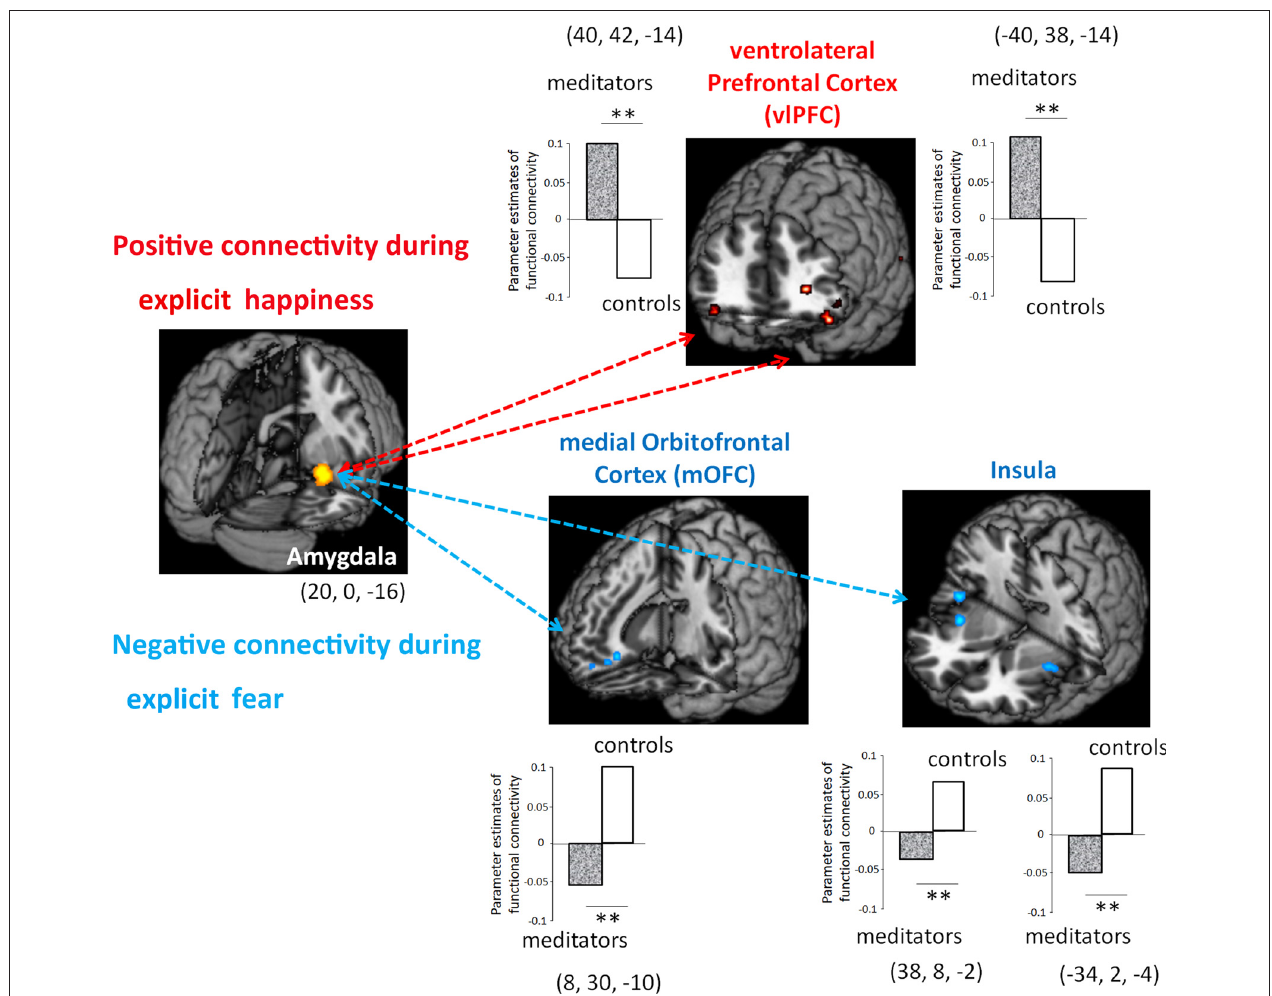
FIGURE 3 | Functional connectivity between meditators and novices during explicit emotional processing. Compared with the novices, the meditators had a significantly more positive connectivity of the amygdala with the ventrolateral prefrontal cortex (PFC) during the processing of happiness, whereas a significantly more negative connectivity of the amygdala with the medial orbitofrontal cortex (OFC) and the bilateral insula during the processing of fear. ∗∗ P <